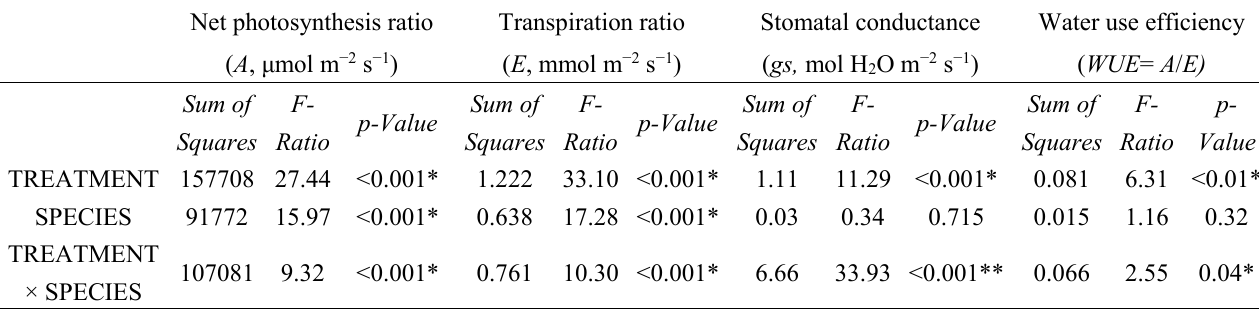
Table 1. F-tests identified post-fire management, induced drought, species and the interaction for the net photosynthesis ratio ( A , μmol m −2 s −1 ), transpiration ratio ( E